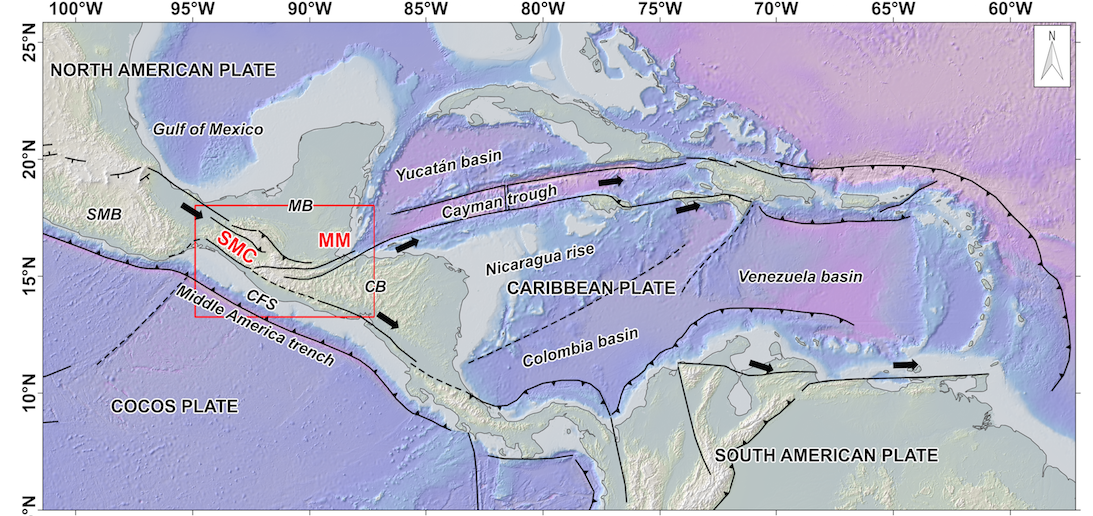
Figure 1. Main plate boundaries in Central America (black lines) and location of the Sierra Madre de Chiapas (SMC) and Maya Mountains (MM) in red. The red box shows the extent of Fig. 2. Abbreviations: CB – Chortis block; CFS – Central America forearc sliver; MB – Maya block; SMB – southern Mexico block. Topography and bathymetry from the General Bathymetric Chart of the Oceans (GEBCO,